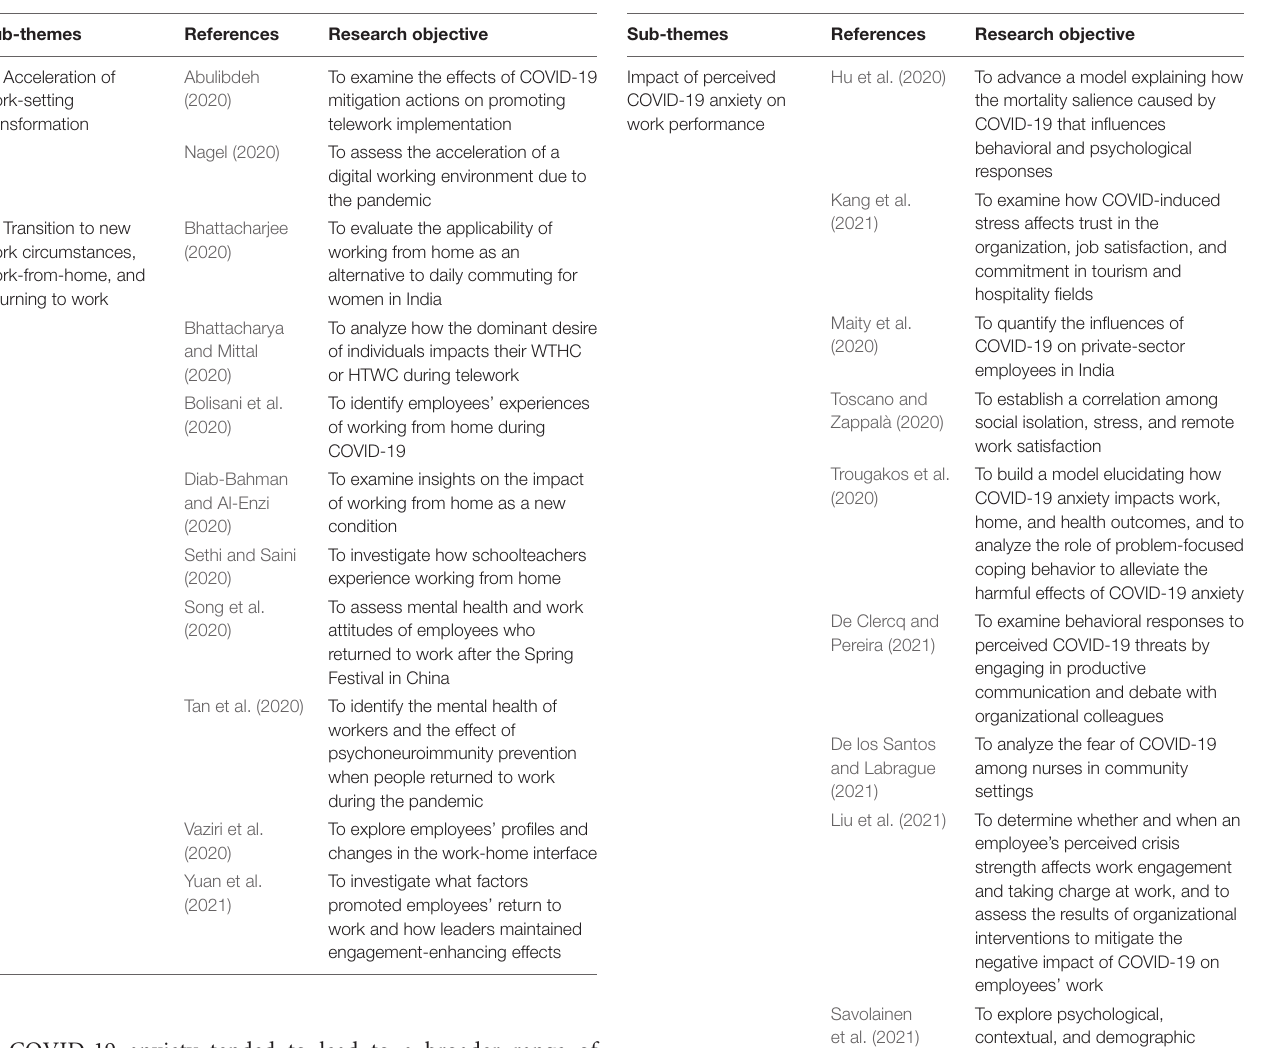
TABLE 2 | Articles on work setting. TABLE 3 | Articles on perceptions of